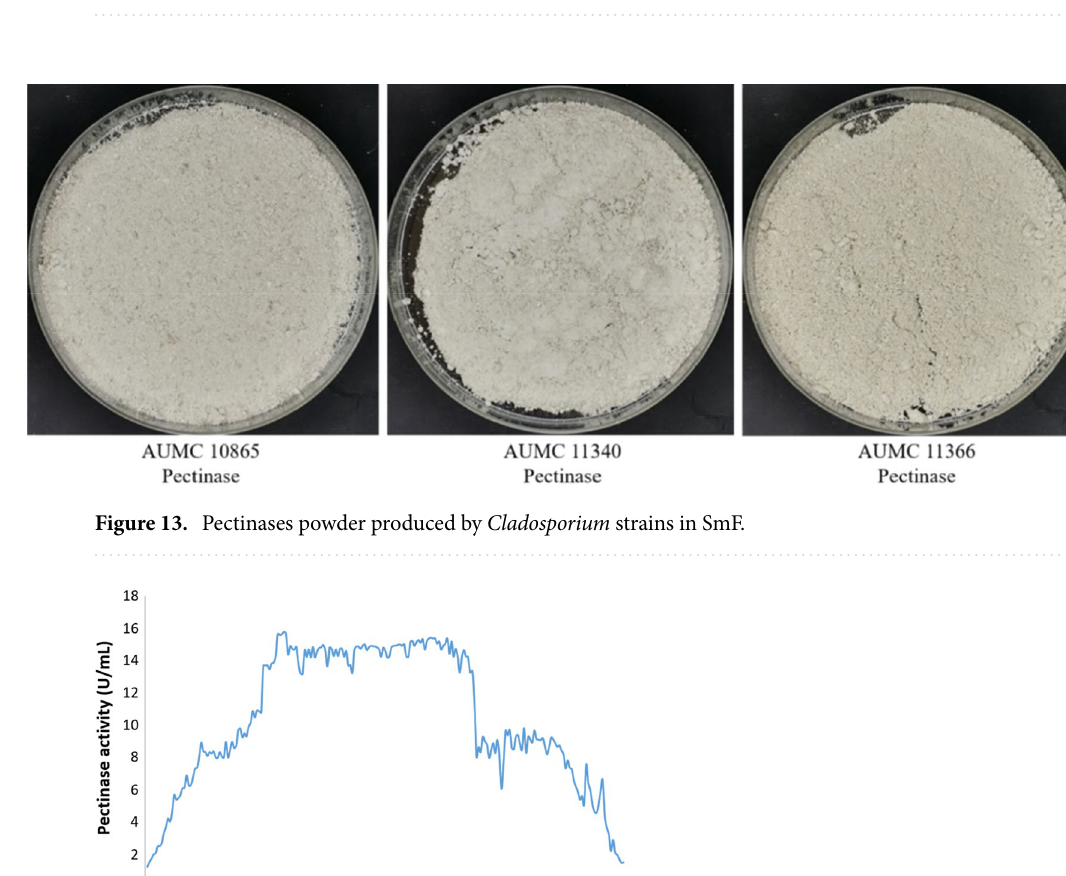
Figure 12. Effect of nitrogen source and incubation time on the pectinase production by C. compactisporum AUMC 11366 at pH 7.0 and 5 °C after 9 days.